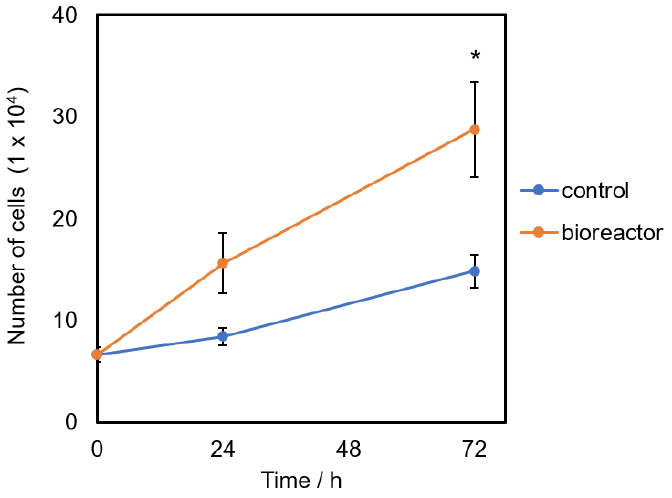
Figure 11. Cell proliferation of L929 incubated in the developed bioreactor. The number of cells was counted at 24 and 72 h after incubation and the data were analyzed by two-way ANOVA and post-hoc using R program. * Statistical significance was set at p < 0.05, n = 3.